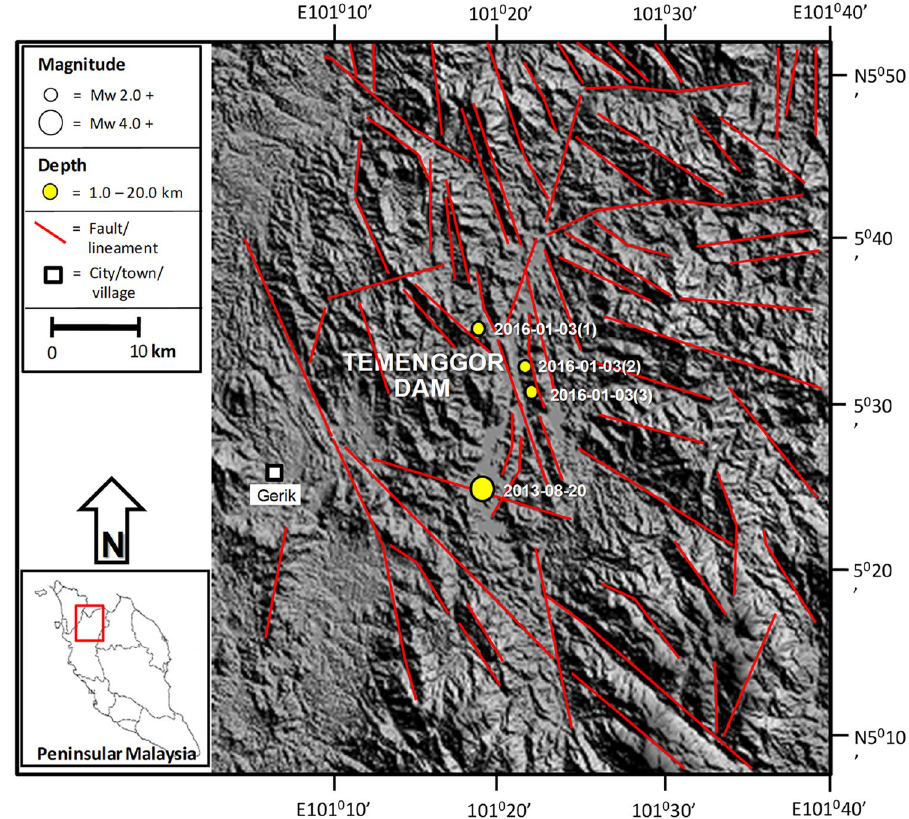
Fig. 10 Epicenters distribu- tion of the Temenggor Dam earthquakes in 2013 and 2016 plotted on the SRTM–DEM image. Red thinner lines here are lineaments indicating pos- sible faults. Note: Created with